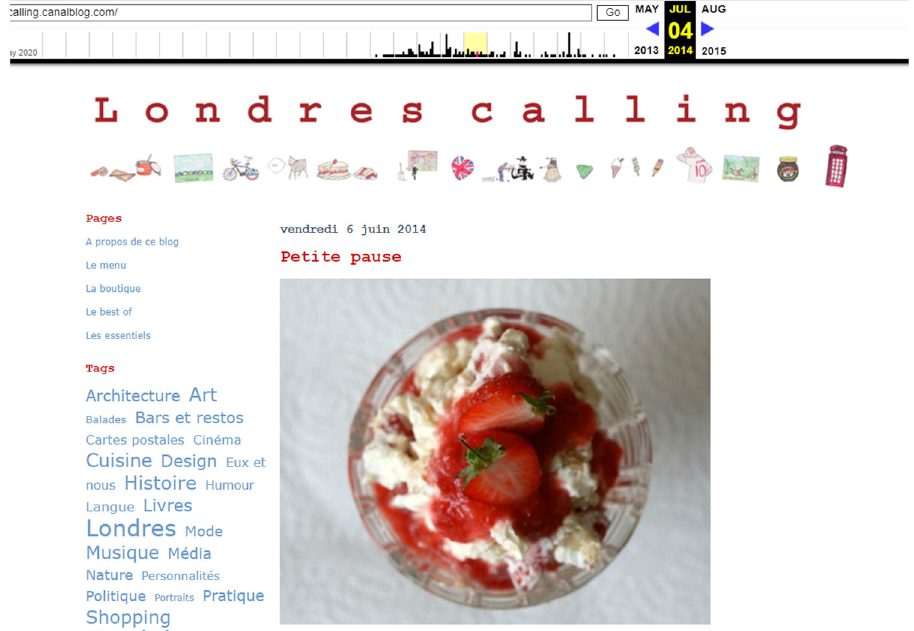
Fig. 5 Londres Calling blog landing page, archived 04 July 2014. The original telephone-booth banner has been replaced by a culturally sensitised graphic-novel-style suite of images that connect it to the London-French blogosphere and embed it in a transnational space. This fi gure is not covered by the Creative Commons Attribution 4.0 International License. Reproduced with permission of Léa Teuscher; copyright ©londrescalling.blog, all rights